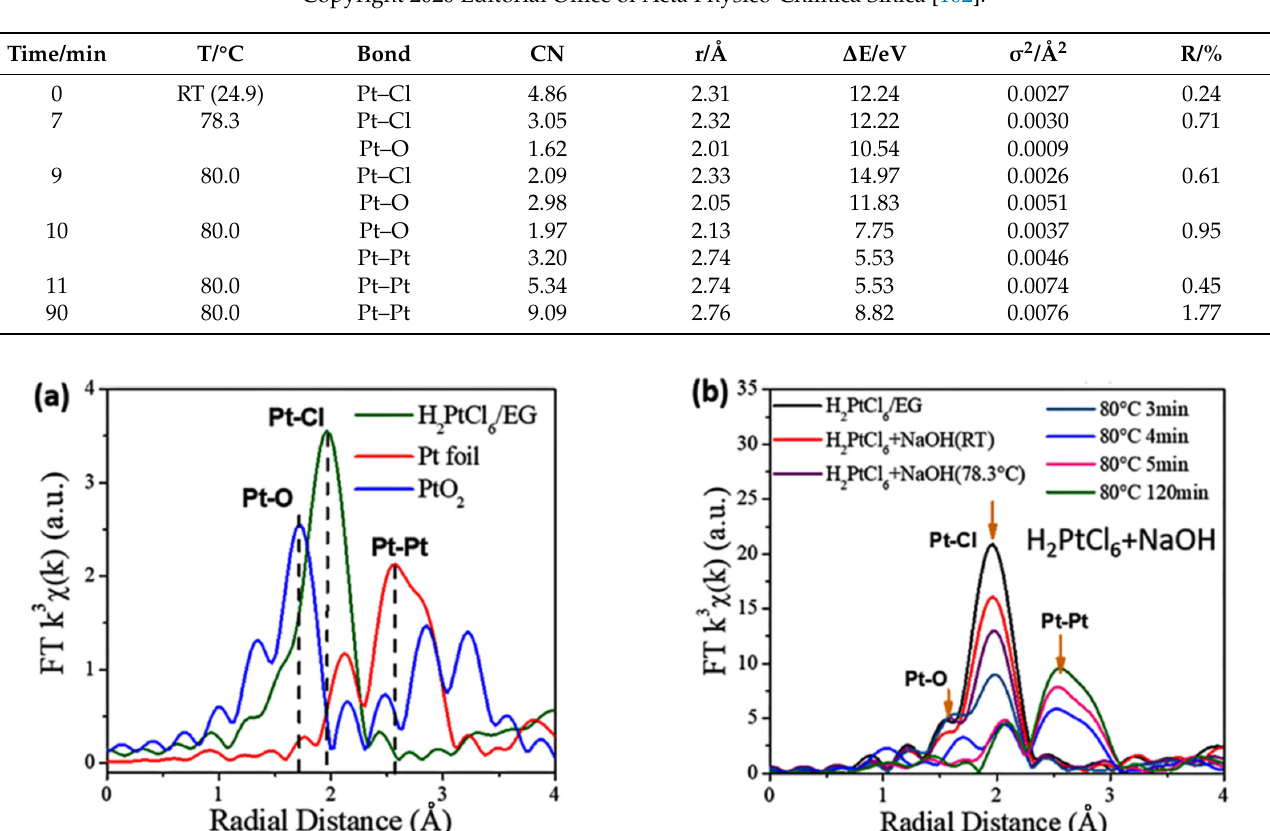
Figure 5. Fourier transforms of k 3 ‐ weighted Pt L 3 ‐ edge EXAFS spectra (radial distribution function). ( a ) The reference of Pt foil, glycol solution of H 2 PtCl 6 and PtO 2 ; ( b ) the reaction mixture for preparing unprotected Pt nanoclusters under different conditions. Reproduced with permission, Copyright